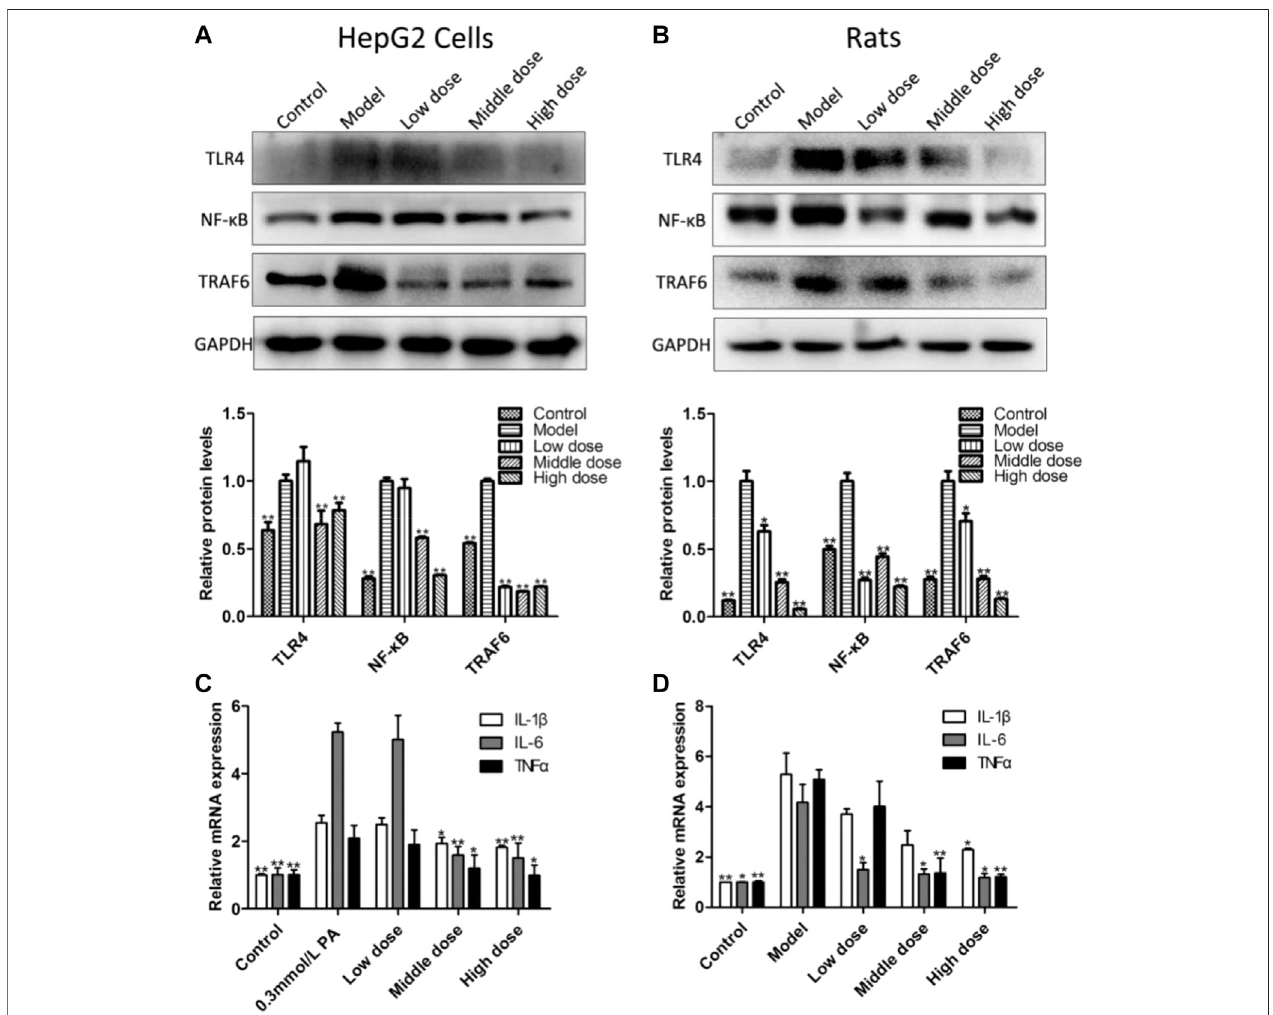
FIGURE 6 | Effect of aromatic vinegar on the levels of some proteins related to in fl ammation and in fl ammatory mediators. (A) Effects of aromatic vinegar on the protein levels of toll-likereceptor-4 (TLR4), nuclear transcription factor- κ B (NF- κ B) and tumor necrosis factor receptor-associated factor-6 (TRAF6) in vitro ; (B) Effects of aromatic vinegar on the protein levels of TLR4, NF- κ B and TRAF6 in vivo ; (C) Effects of aromatic vinegar on the mRNA levels of tumor necrosis factor- α (TNF- α ), interleukin-1 β (IL-1 β )andinterleukin-6(IL-6) invitro ; (D) EffectsofaromaticvinegaronthemRNAlevelsofTNF- α ,IL-1 β andIL-6 invivo .Valuesareexpressedasthe mean ± SD (n (cid:2) 3). * p < 0.05, ** p < 0.01 compared with model